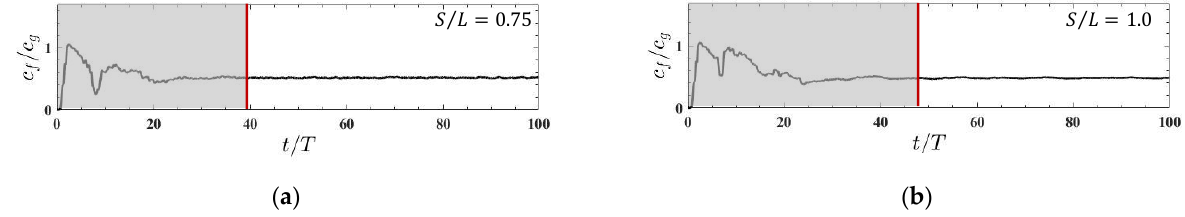
Figure 7. Time history of the variation in the group velocity 𝑐 𝑓 𝑐 𝑔 ⁄ at 𝑥 𝑑⁄ = 0 for 𝑚 = 3 . ( a ) 𝑆 𝐿⁄ = 0.75 . ( b ) 𝑆 𝐿⁄ = 1.0 .